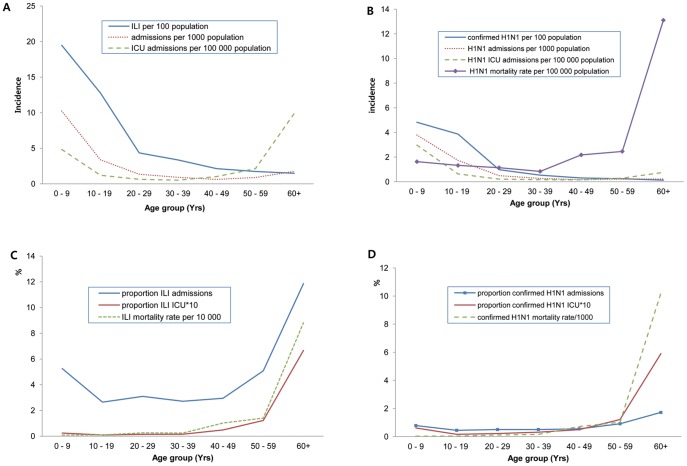
Epidemic curves of confirmed or suspected influenza A (H1N1) (A) and confirmed only (B).Proportion of severe outcomes among confirmed or suspected influenza A (H1N1) cases by age group (C) and confirmed cases only (D).